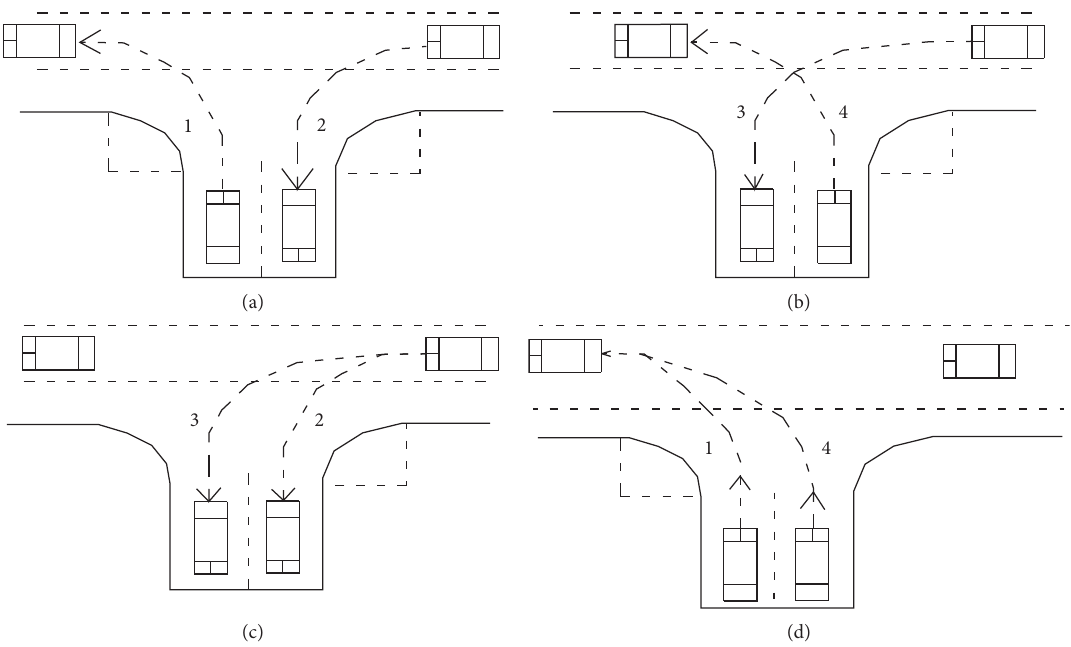
Figure 9: Combinations of left-turning movements. (a) Entering and exiting turns at the near side of the curb. (b) Entering and exiting turns at the far side of the curb. (c) Entering turns at the near and far side of the curb. (d) Exiting turns at the near and far side of the